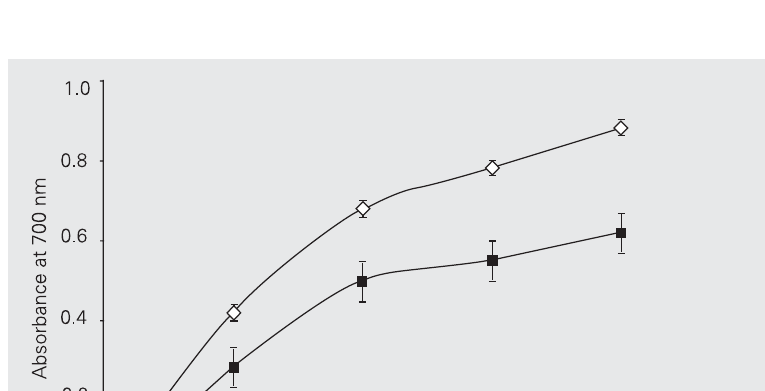
Figure 1. Inhibition (%) of lipid peroxidation in a linoleic acid emulsion by different doses of the methanol extract of Bauhinia racemosa (MEBR) and by α -to- copherol ( α -Tph). Data are re- ported as means ± SD of three measurements. *P < 0.05 com- pared to control (C; ANOVA fol- lowed by the Student t -test).